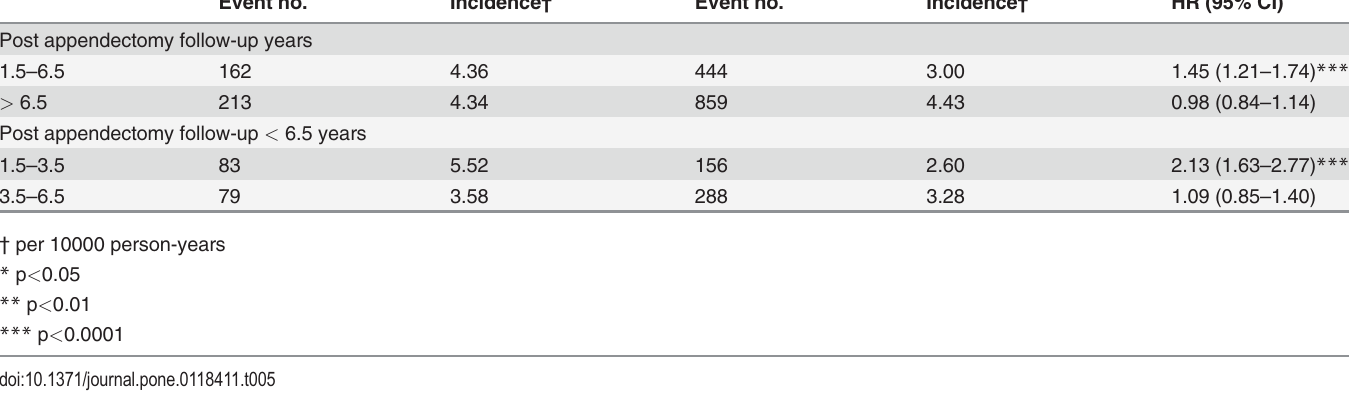
Table 5. Incidence and hazard ratio of colorectal cancer during post appendectomy follow-up.